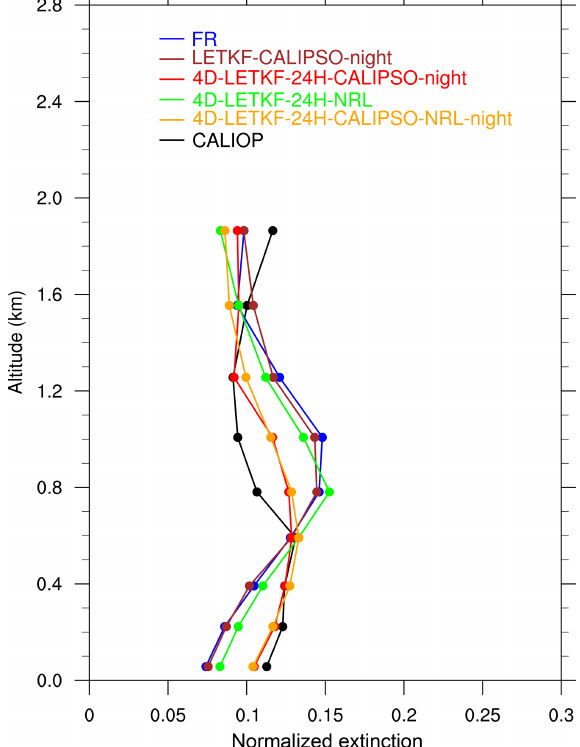
Figure 14. Averaged monthly mean vertical profiles of the simu- lated normalized aerosol extinction coefficients in the daytime at 550nm (km − 1 ) in the five experiments and the CALIOP-observed ones in the daytime at